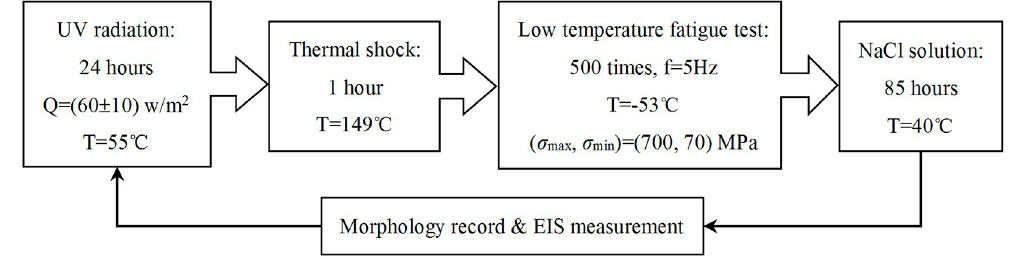
Figure 2. Acceleration test process.